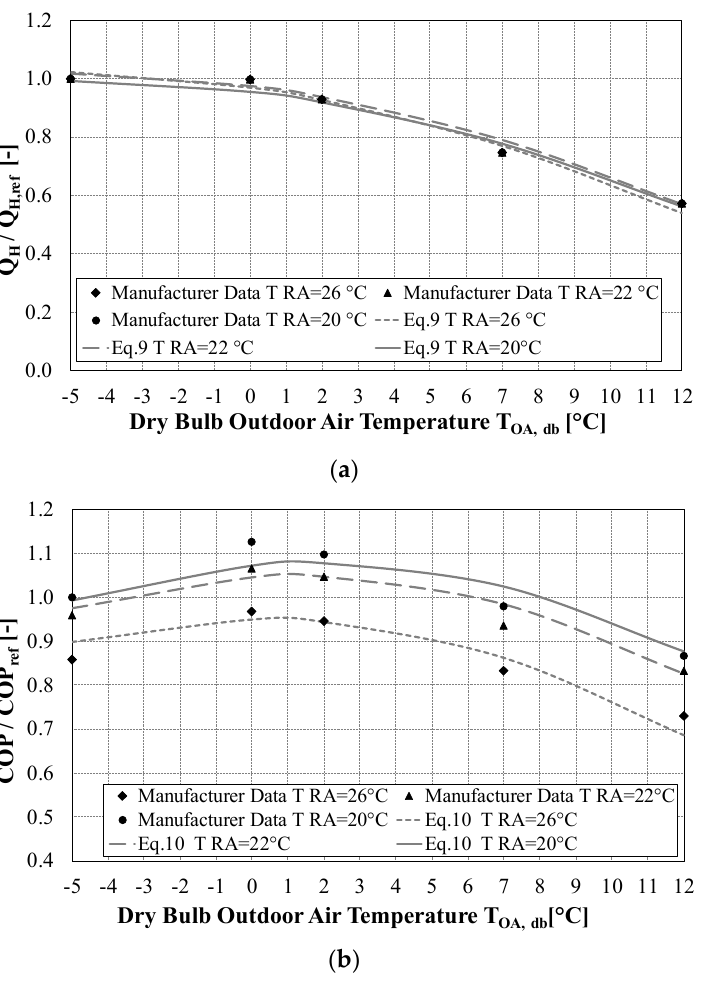
Figure 5. Heating capacity ( a ) and HP performance ( b ) in heating mode: comparison between Table 6 and Equations (9) and (10) with Table 7 coefficients.